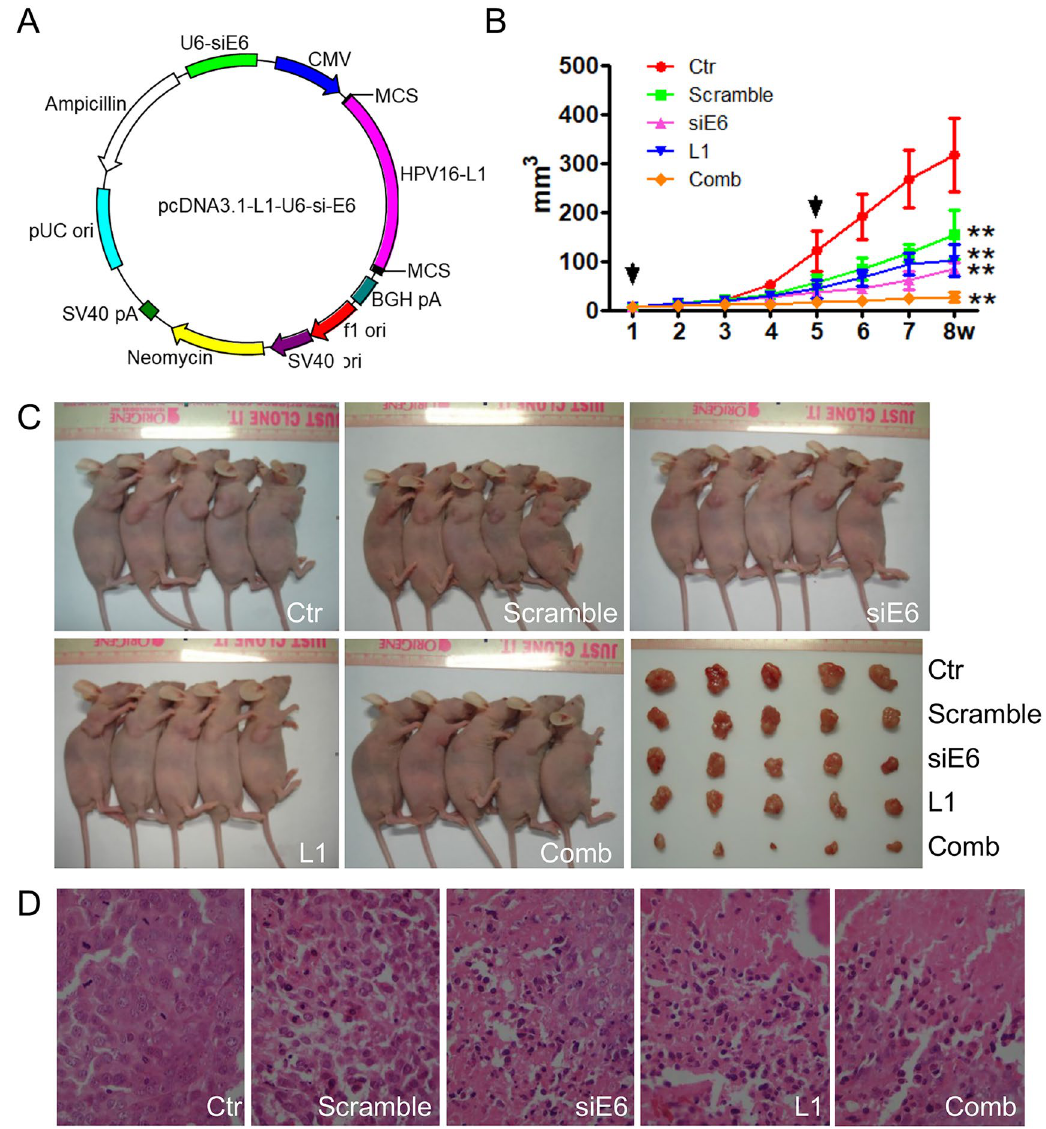
Figure 6. The phoP/phoQ(pcDNA3.1- L1-siE6) can inhibit the growth of the xenograft tumors in vivo. ( A ) The map of pcDNA3.1- L1-siE6. ( B , C ) Growth of Siha xenografts treated with attenuated Salmonella phoP/phoQ. Each treatment with the plasmid is shown an arrow. **P < 0.01, vs the two control groups. ( D ) H&E analysis of Siha xenografts treated with phoP/phoQ (×